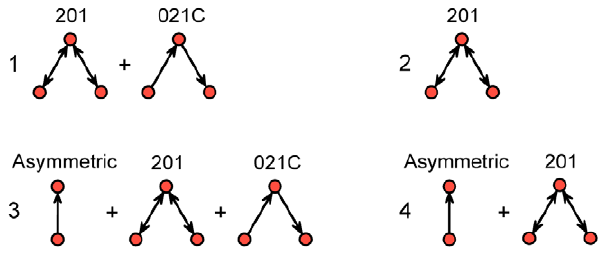
Figure 7. Graphical representation of our four exponential random graph models. The triads are given conventional number- ing; see Figure S4 for a complete overview of all possible dyads and